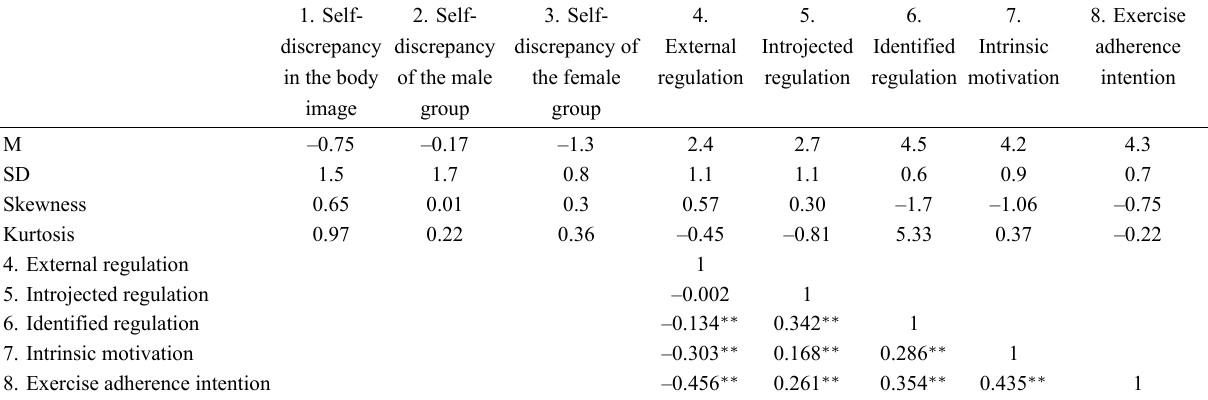
Table 3. Descriptive statistics analysis and correlation